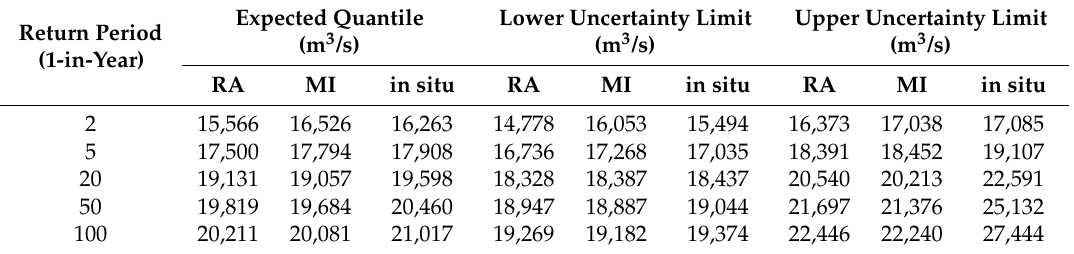
Table 8. Onitsha flood quantile estimates and uncertainty boundaries for in situ, MI, and RA filled